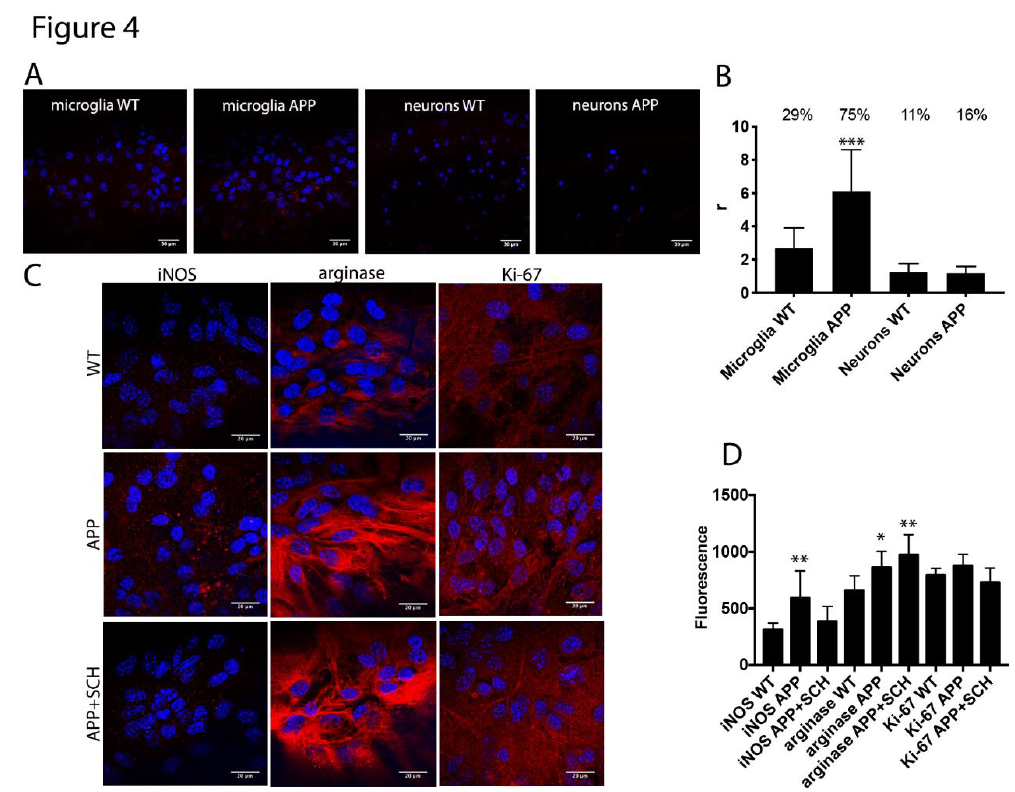
Figure 4. Microglial markers in primary cultures from APP Sw,Ind mice. In ( A,B ), proximity ligation assays (PLAs) were performed in microglial and in the hippocampus neuronal primary cultures of control (WT) and APP Sw,Ind mice using primary antibodies specific for A 2A and NMDA receptors. In all cases, the cell nuclei were stained with Hoechst (blue). The confocal microscopy images are shown (superimposed sections) in which the heteromers appear as red clusters (in neurons or microglia). Scale bars = 30 µ m (neurons and microglia). The bar graph ( B ) shows the number of red dots / cell (r) and the numbers above the bars indicate the percentage of cells presenting red dots. Values are the mean ± SEM ( n = 6). A one-way ANOVA followed by Bonferroni’s multiple comparison post-hoc test were used for statistical analysis (*** p < 0.001, versus WT -control-). In ( C , D ), immunocytochemical assays were performed in the primary cultures of microglia APP Sw,Ind mice or control (WT) animals pretreated or not for one week with the A 2A R antagonist SCH-58261. The staining was performed using the antibodies that detected either arginase-1 marker, the antiproliferation cell protein Ki-67 or nitric oxide synthase and a Cy3-conjugated secondary antibody (red). The fluorescence was quantified in all the panels using the Fiji program and normalization by cell number. Representative images in all conditions are shown in ( C ). A one-way ANOVA followed by Bonferroni’s multiple comparison post-hoc test were used for statistical analysis (* p < 0.05, ** p < 0.01; versus